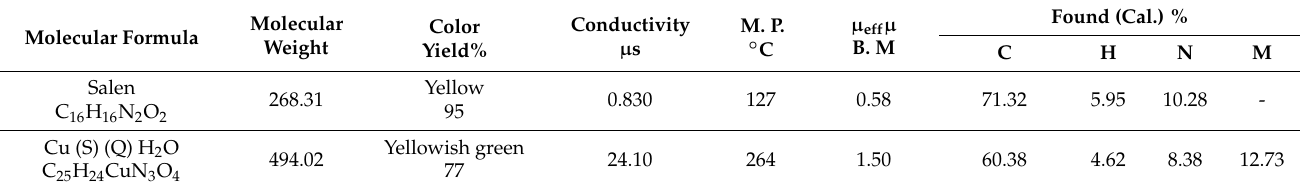
Table 1. Analytical data of Salen and its CuSQ mixed ligand complex of 8-hydroxy quinolone. Molecular Molecular Formula